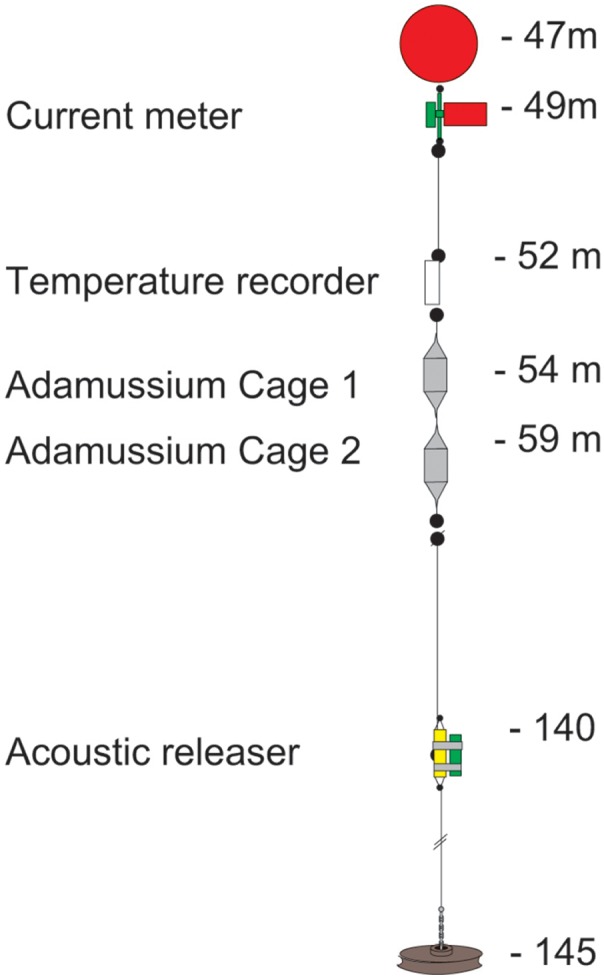
The mooring “L” array.